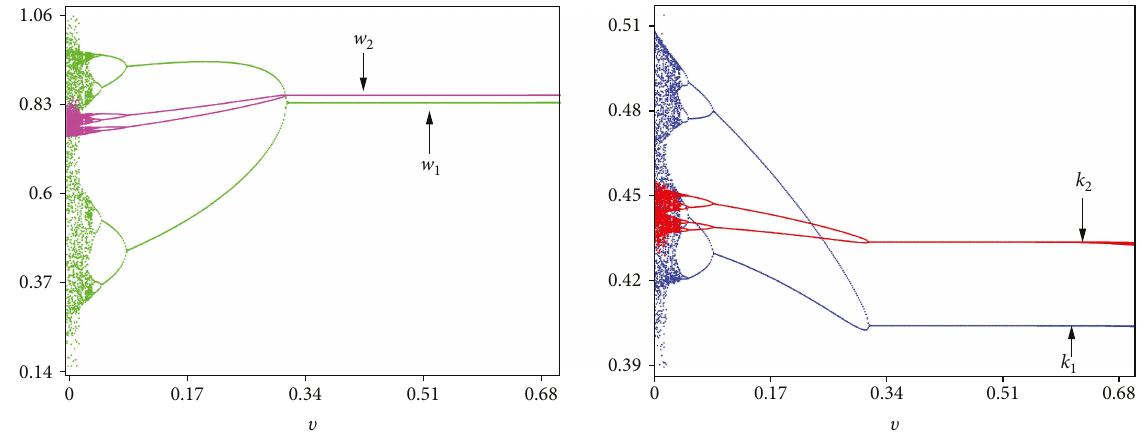
Figure 21: Bifurcation diagram when υ varies from 0 to 0.7 and g